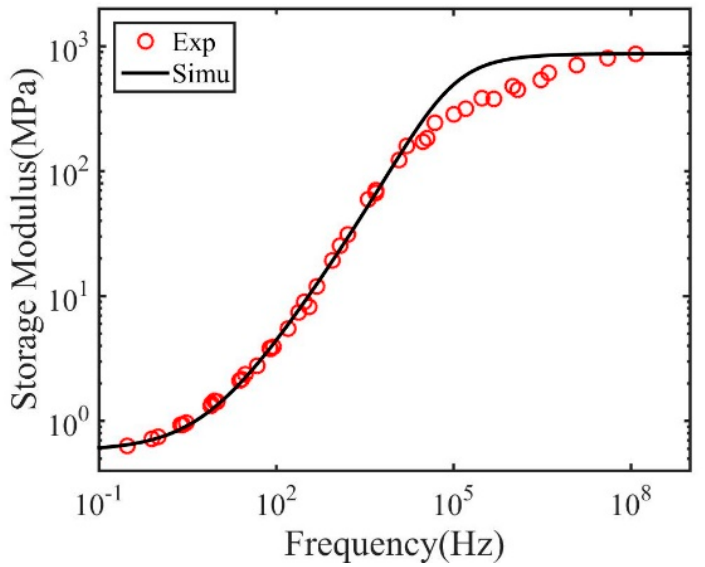
Figure 3. Measured and fitted master curve for dry polymers with 2 wt.% crosslink density. Table 4. Parameters of the fractional Zener model for polymers with 2 wt.% crosslink density. Parameter